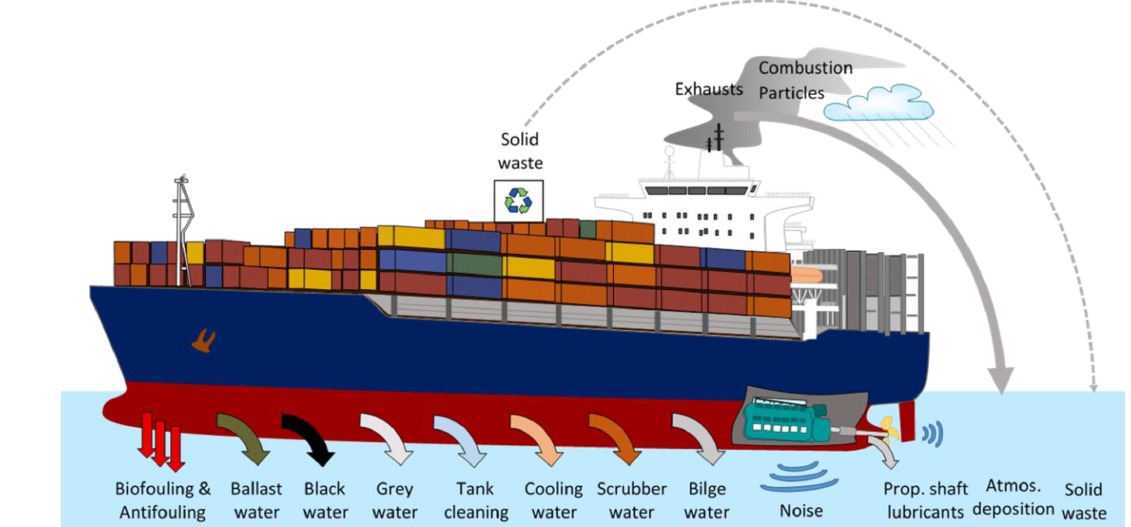
Figure 3. Different impacts of shipping on the environment. Hydrodynamic impacts such as wakes are not shown but described in the text. Courtesy of Moldanová et al. (2018),